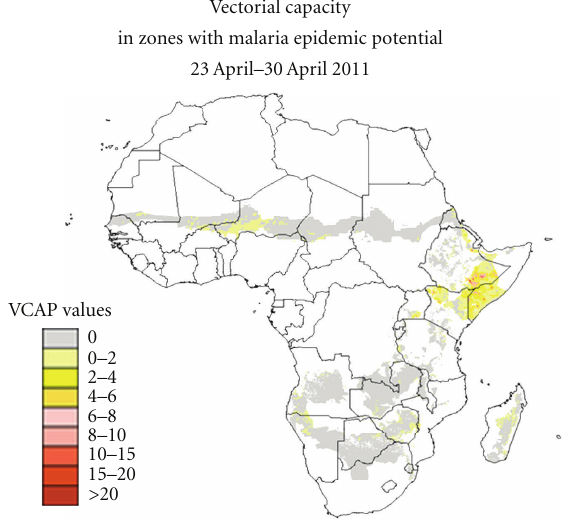
Figure 2: Vectorial capacity map produced by USGS EROS Center. The VCAP values are provided for the epidemic zones of Africa at 1km spatial resolution. The map has been updated every 8 days since January